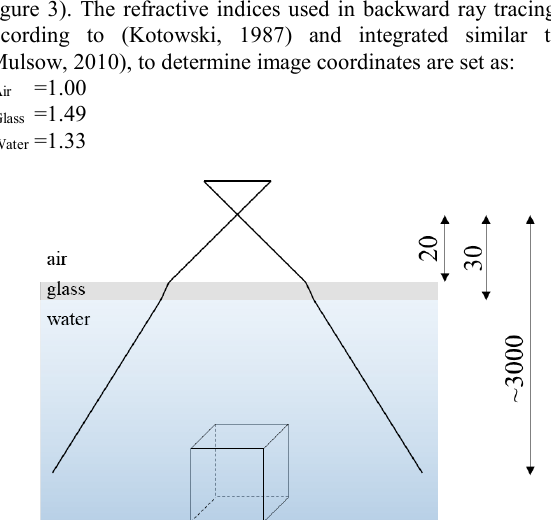
Table 1. Interior orientation parameters (principal distance and radial distortion) of one single-medium dataset and one multimedia